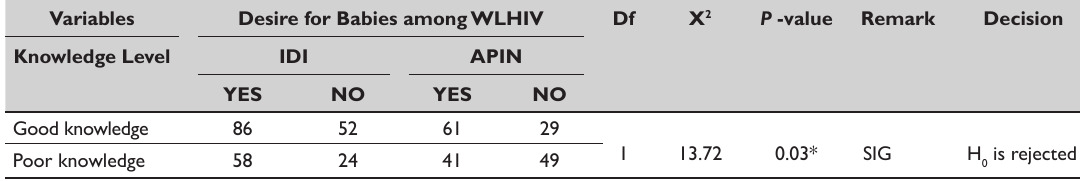
Table 8: Knowledge level of contraceptive options and desire for babies among study